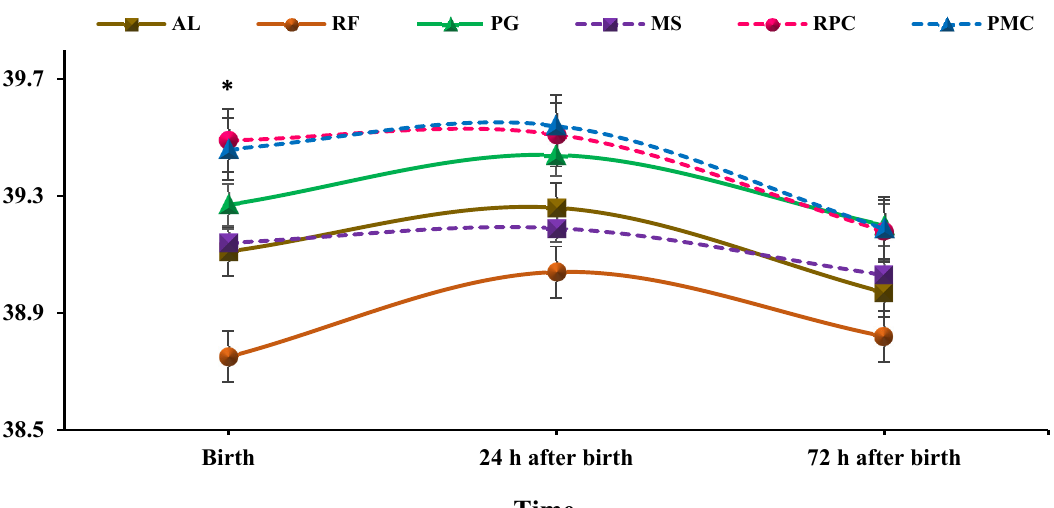
Figure 3. Effect of feed restriction and supplementation with propylene glycol, monensin sodium, and rumen-protected choline chloride in late pregnancy on the rectal temperature of lambs during the first three postnatal days. AL = ad libitum feed intake; RF = restricted feeding; PG = restricted feeding plus propylene glycol; MS = restricted feeding plus propylene glycol and monensin sodium; RPC = restricted feeding plus propylene glycol and rumen-protected choline chloride; PMC = restricted feeding plus propylene glycol, monensin sodium, and rumen-protected choline chloride. Values are means with their standard errors being shown by vertical bars. Mean values differ significantly at each time point: * p < 0.05.